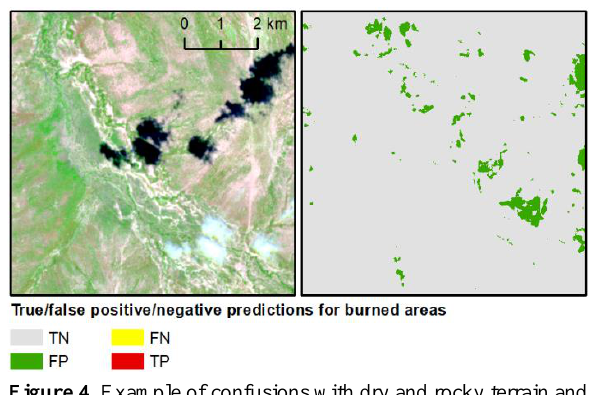
Figure 4 . Example of confusions with dry and rocky terrain and reliable classification of cloud shadow as non-burned in the use case example in Central Africa (RGB composition: